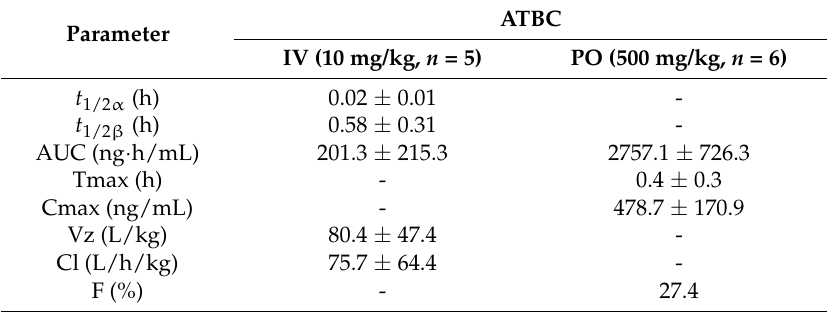
Figure 3. Plasma concentration-time profile of ATBC after ( a ) IV administration of 10 mg/kg of ATBC and ( b ) PO administration of 500 mg/kg to rats. Data were expressed as mean ± SD. Table 3. Pharmacokinetic parameters after intravenous (IV) and oral (PO) administration of ATBC to rats.